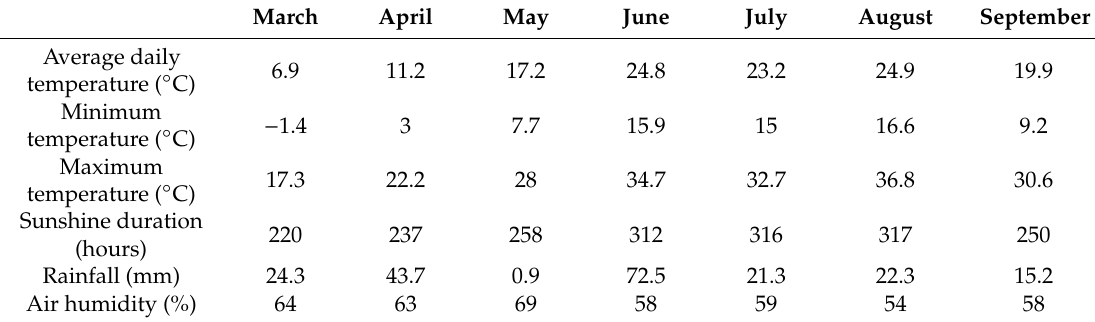
Table 7. Values of meteorological parameters relevant to the growing